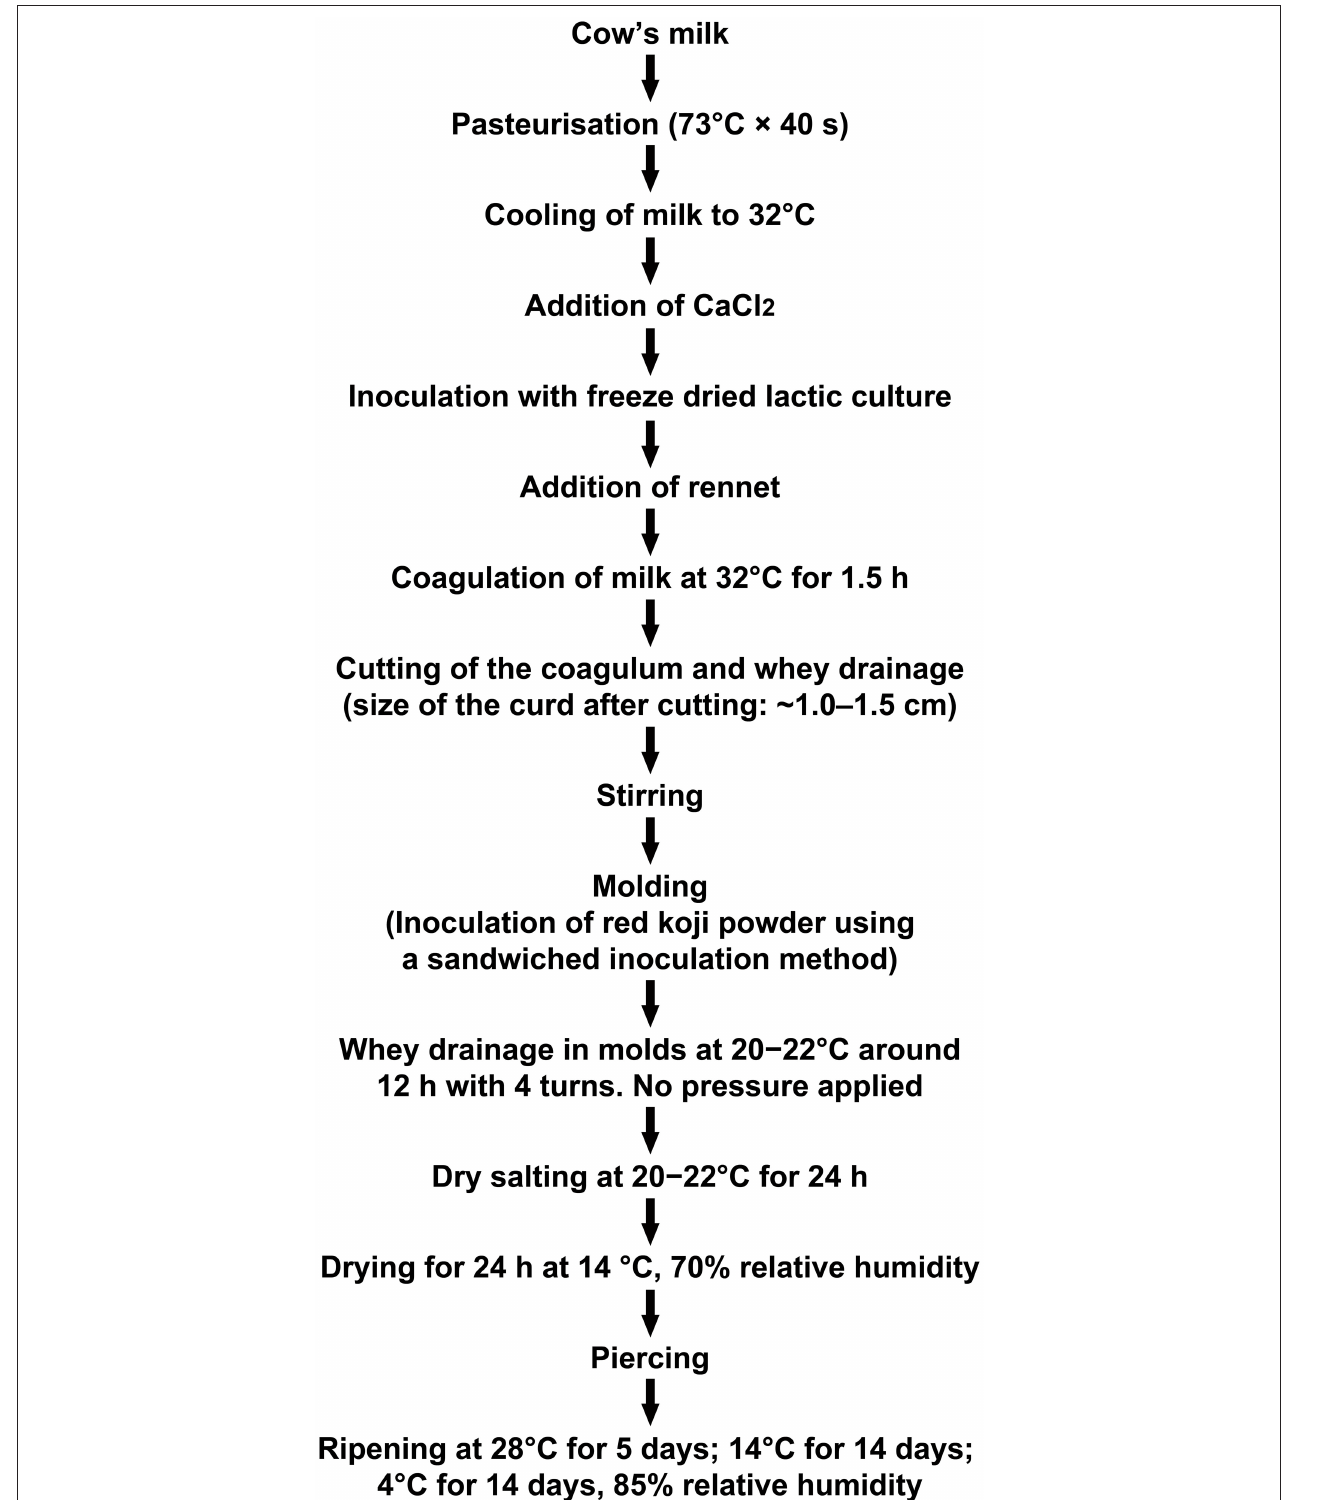
FIGURE 1 | Flow diagram for the production of Red-Veined